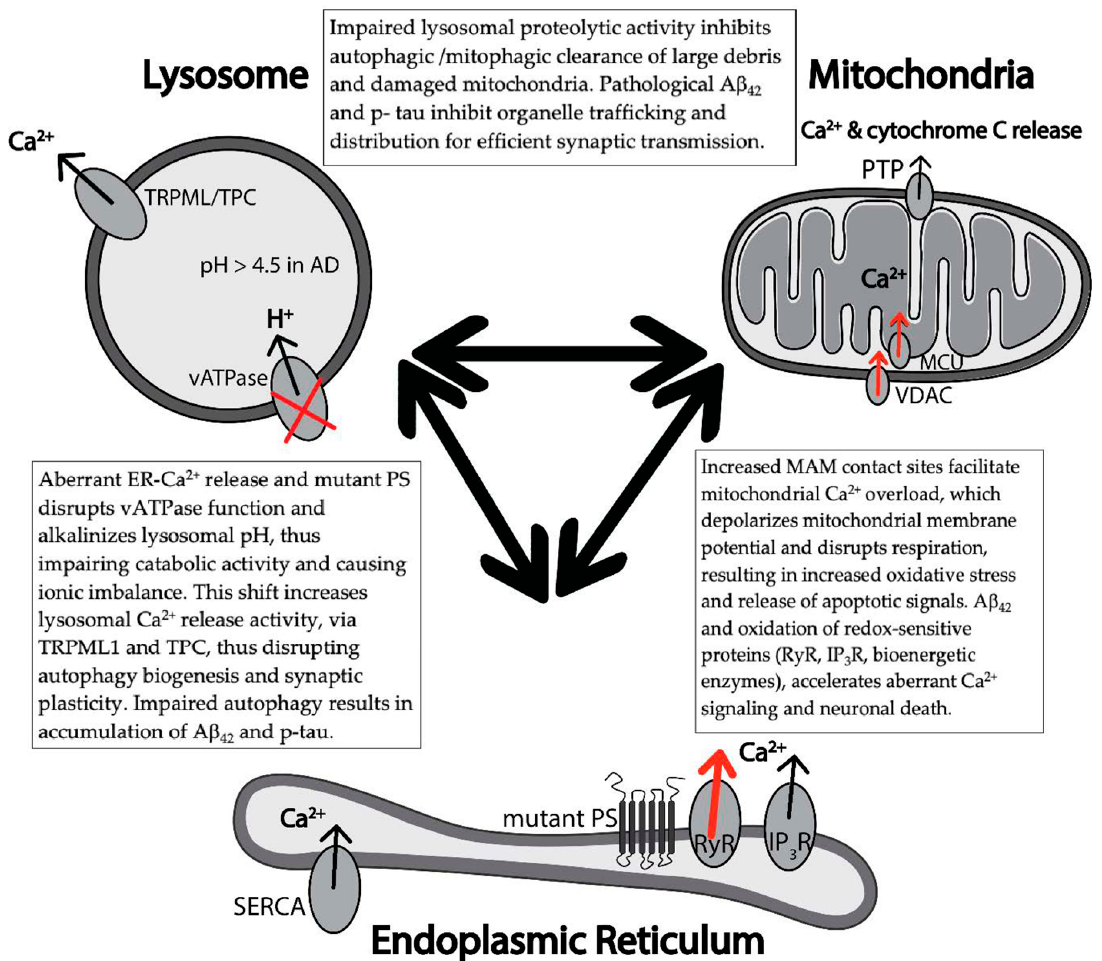
Figure 3. Aberrant Ca 2+ disrupts inter-organelle functional relationships in early AD pathology.